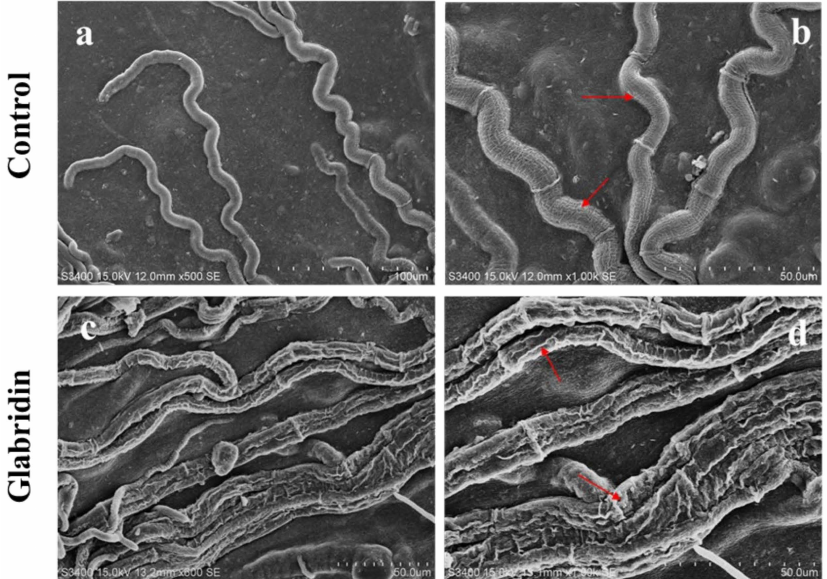
Figure 2. Scanning electron micrographs of S. sclerotiorum mycelia in untreated control ( a , b ) and treated with 10 µ g/mL glabridin ( c , d ). Red arrow represents shrunken hyphae. The scale bar in each subfigure: ( a ) 100 µ m; ( b ) 50 µ m; ( c ) 50 µ m; ( d ) 50 µ